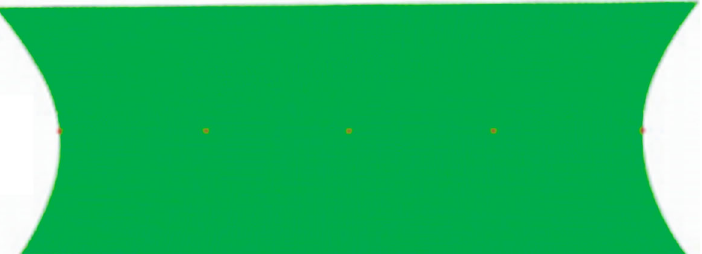
Figure 10: The scallop-shaped treatment on the side edge of the spokes.